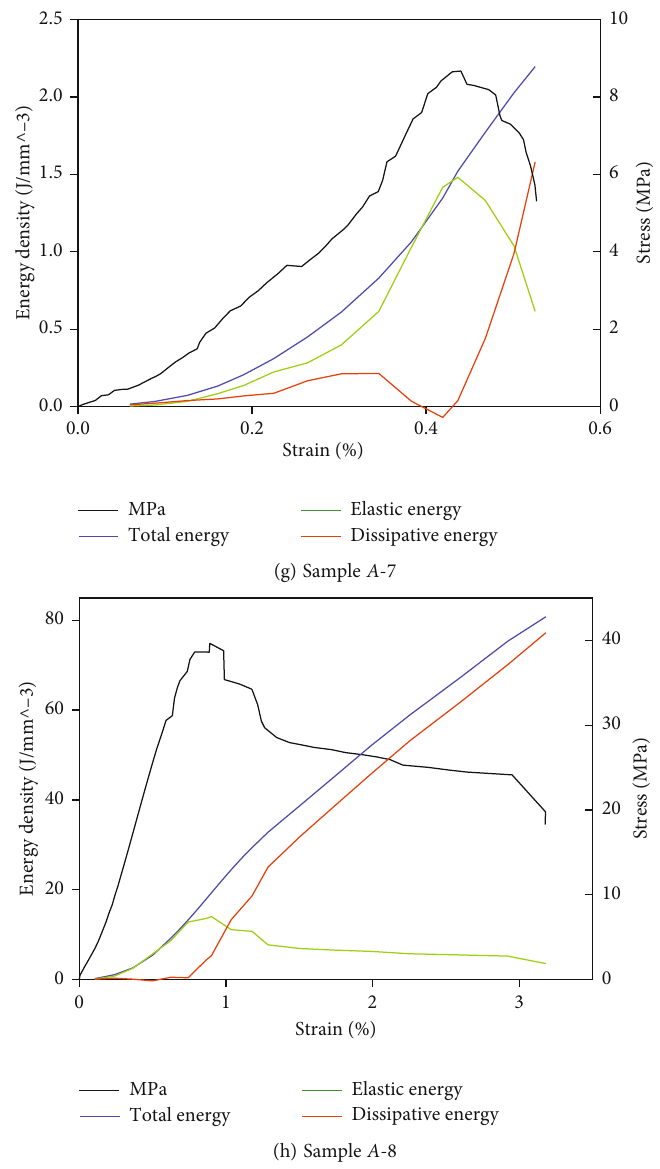
Figure 9: Evolution of strain energy of coal under uniaxial compression. Table 3: Energy characteristics of coal samples with di ff erent water